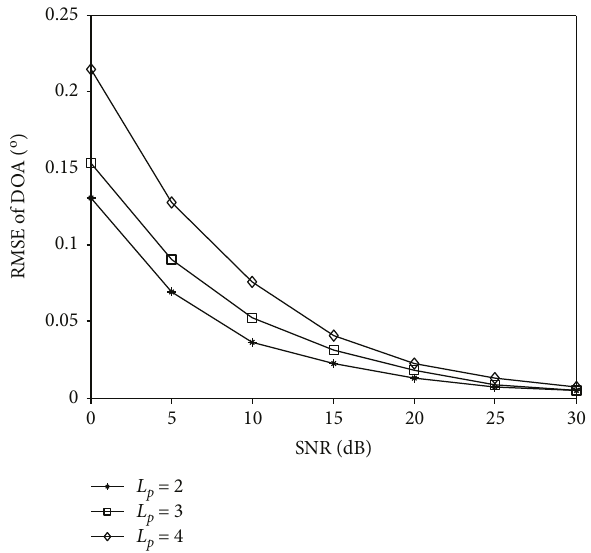
Figure 9: DOA estimation performance of the fi rst path under di ff erent multipath numbers.